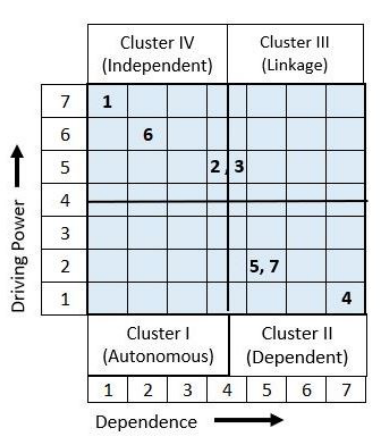
Figure 30. Digraph based on ISM Analysis and Driving